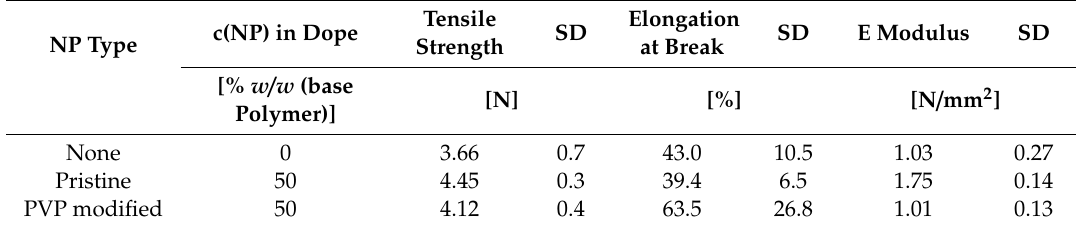
Table 6. Results of the mechanical characterization for various PVDF